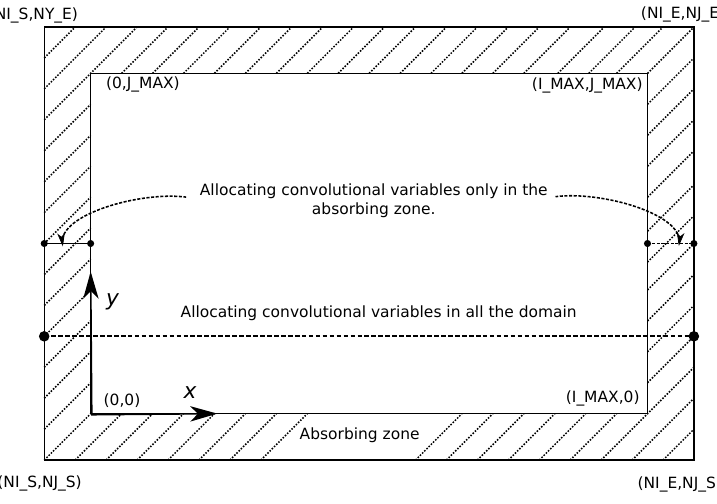
Figure 2. CPML Absorbing Boundary Condition implementation